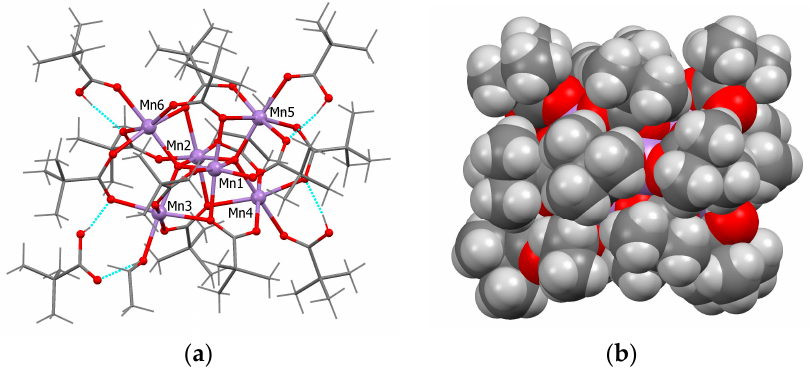
Figure 1. ( a ) View of the cluster and H-bonded pivalic acid molecule in 1 ; ( b ) Space-filling model of the H-bonded associate illustrates the hydrophobic exterior shell of the